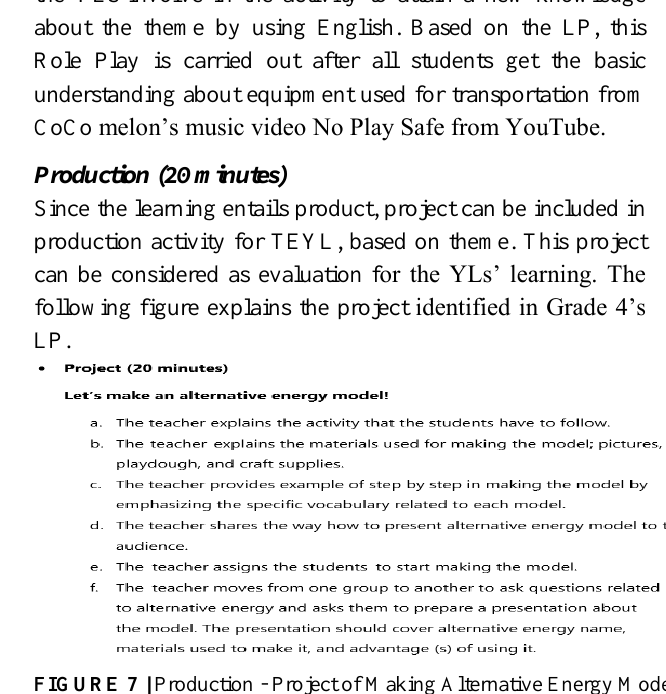
Figure 6 evidences the clear role play procedures to make